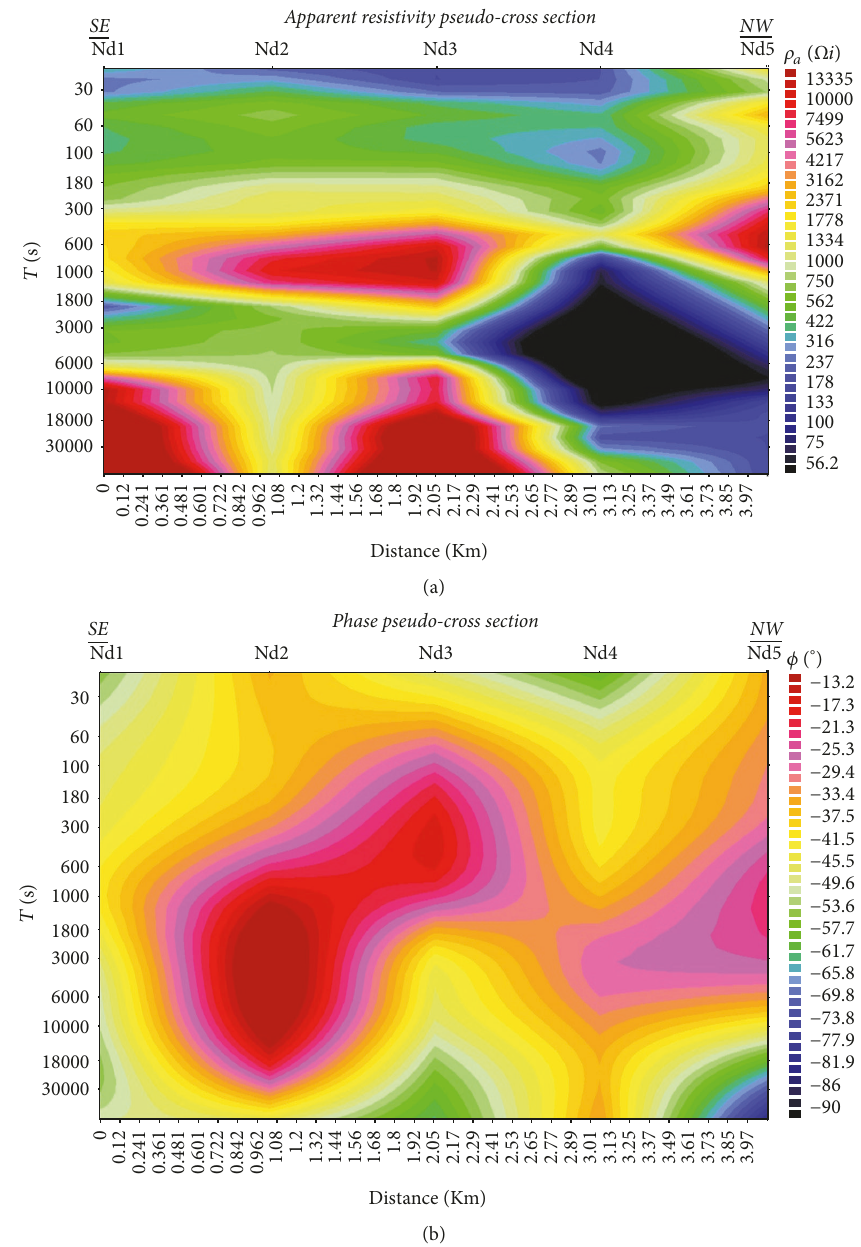
Figure 10: Apparent resistivity (a) and phase (b) pseudo-cross section of Ndokayo